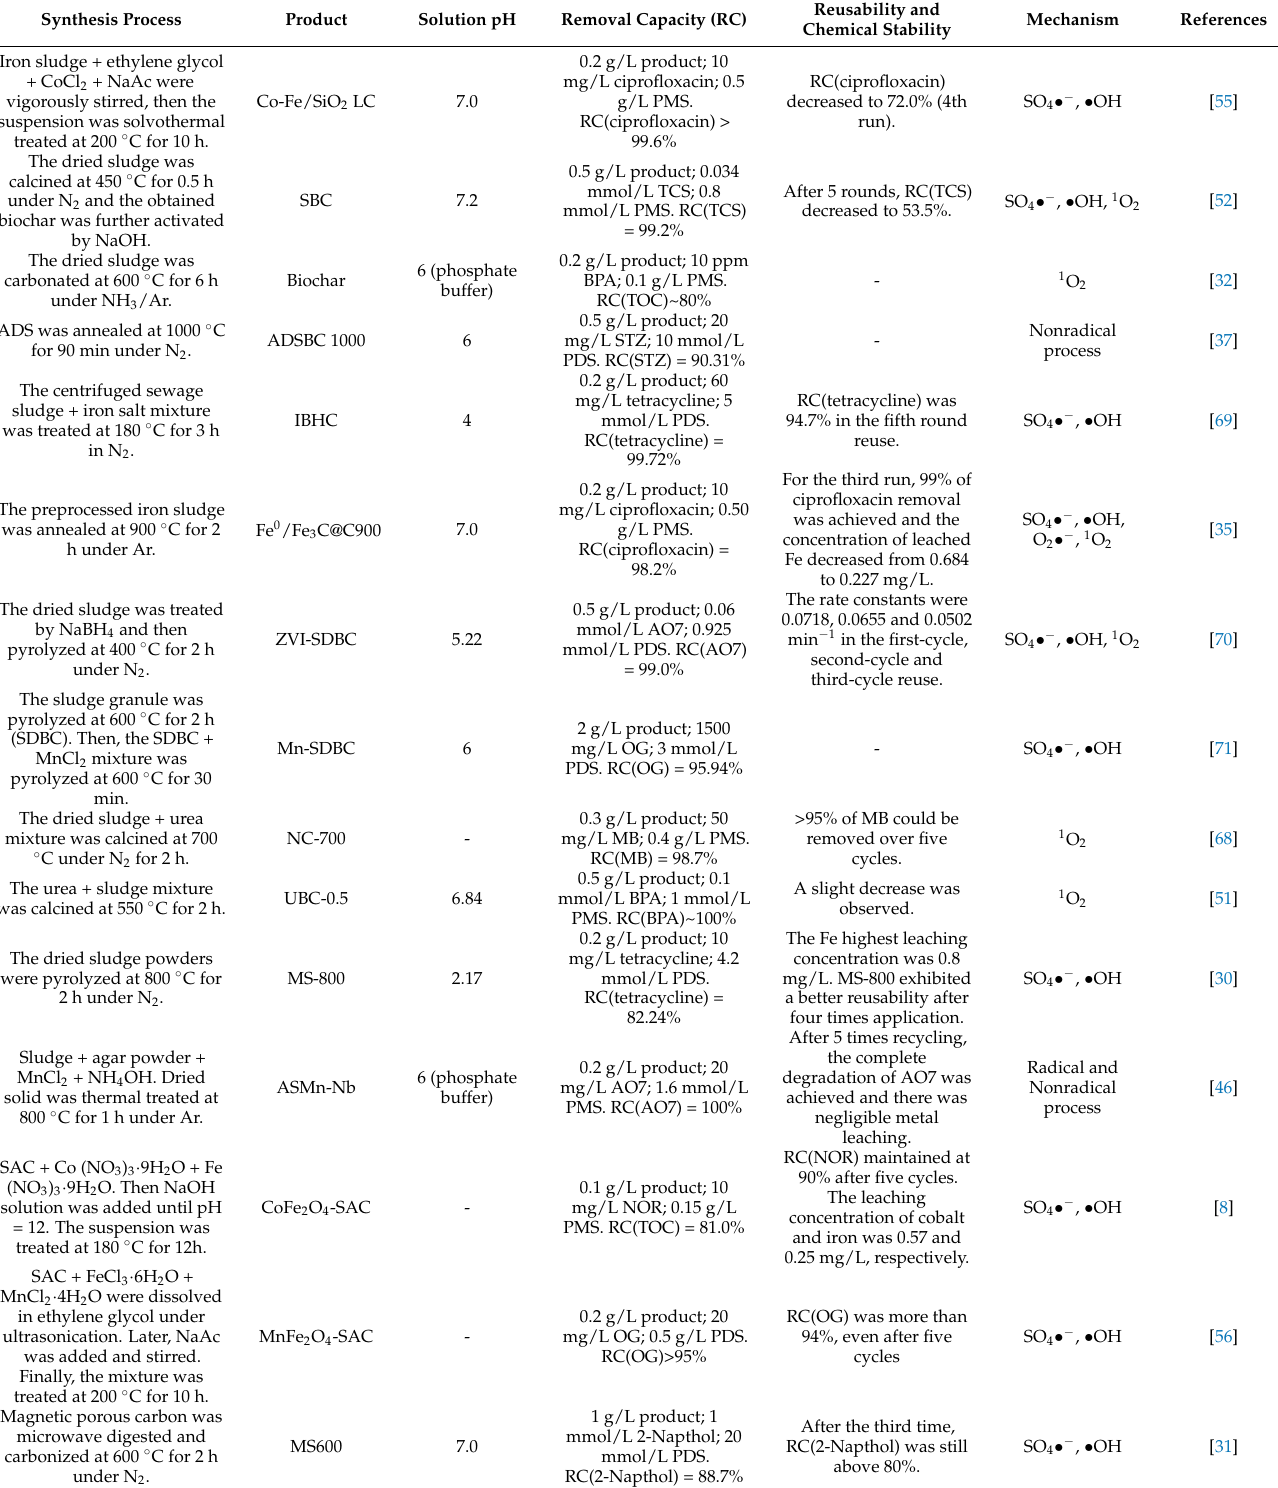
Table 2. Application of sludge-based catalysts in sulfate-based